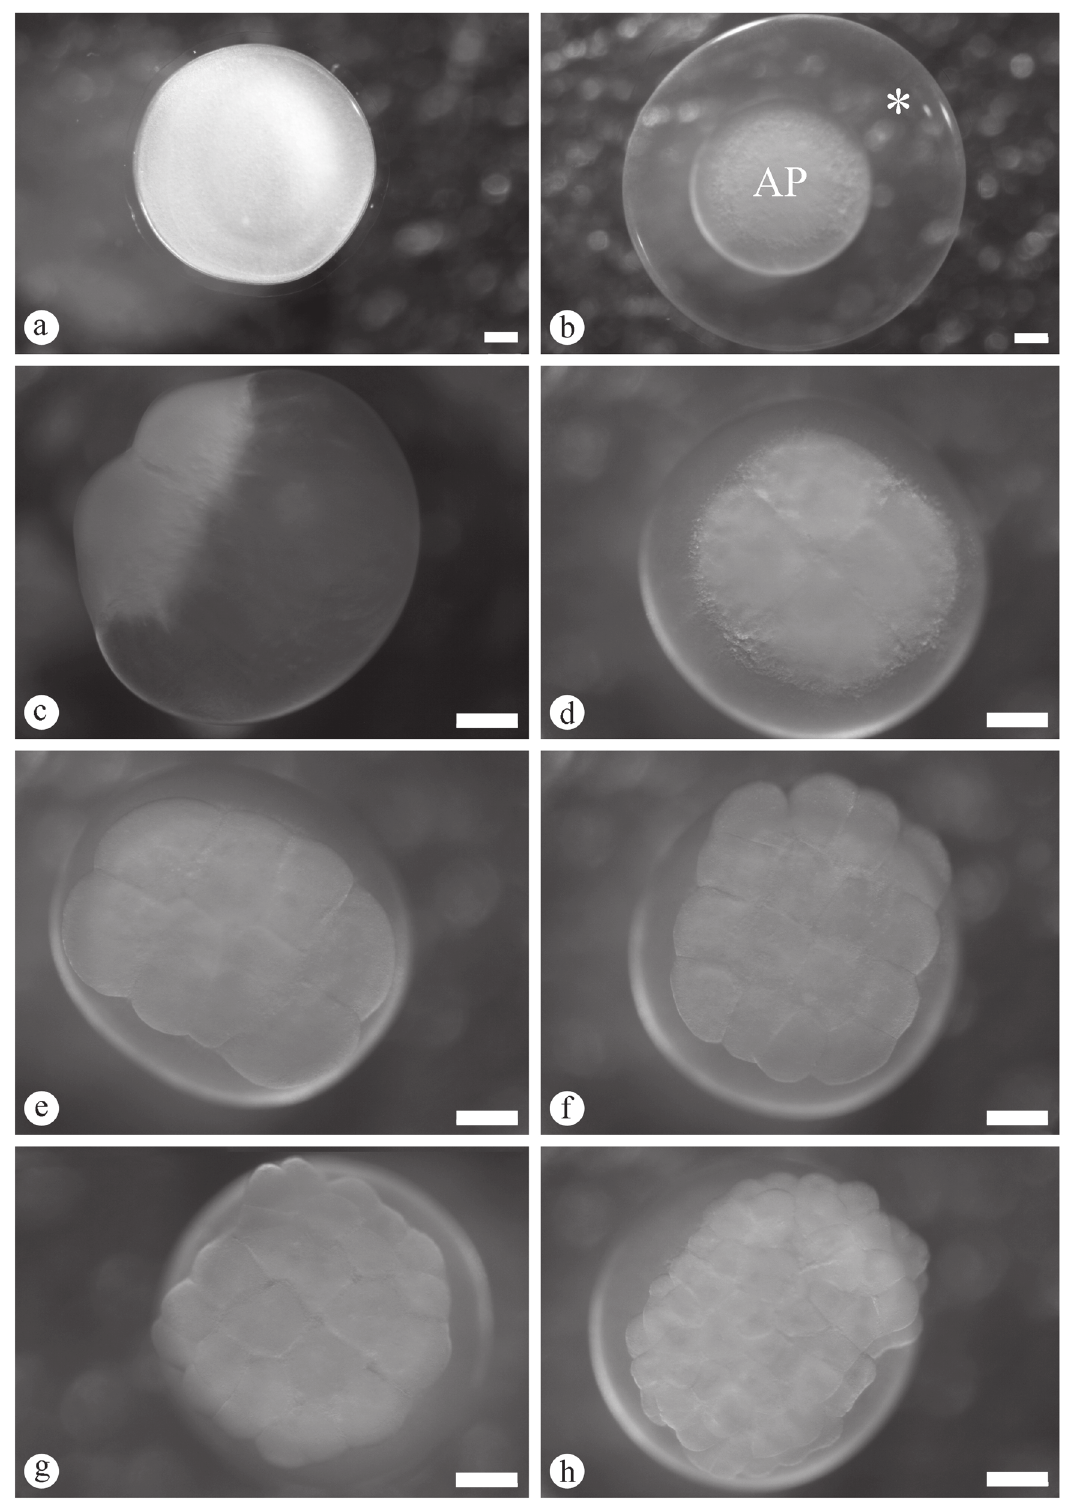
Fig. 2. Macroscopic aspects of embryonic development of Steindachneridion parahybae . a ) oocyte extruded (just after spawning, and before fertilization and hydration) - 1.10 ± 0.10 mm; b ) egg hydrated soon after fertilization (time zero AF) - 1.90 ± 0.60 mm; c ) two blastomeres (1 h 20 min AF); d ) four blastomeres (1 h 40 min AF); e ) eight blastomeres (1 h 50 min AF); f ) sixteen blastomeres (2 h AF); g ) thirty-two blastomeres (2 h 10 min AF); h ) sixty-four blastomeres (2 h 40 min AF). (*): perivitelinic space; (AP): animal pole. Bars: (a-b) 0.2 mm; (c-h) 0.3